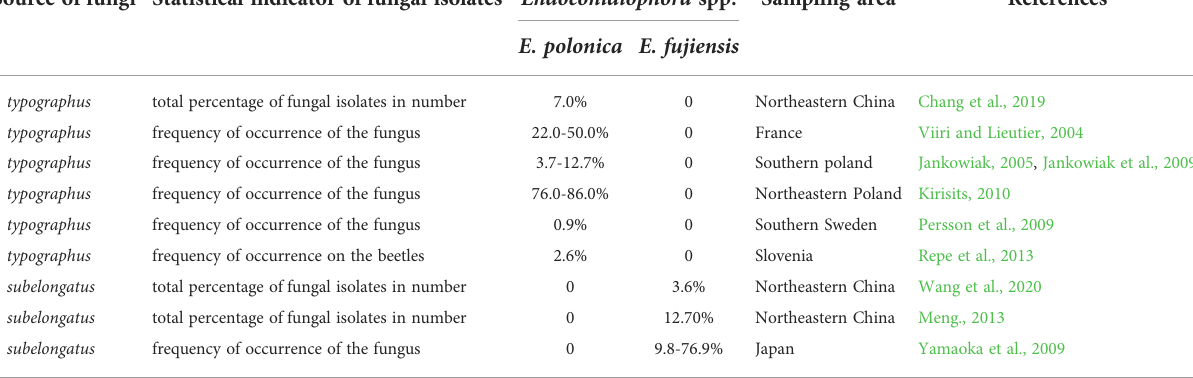
TABLE 1 Selected information from research on Endoconidiophora fungi isolated from two Ips bark beetles. Source of fungi Statistical indicator of fungal isolates Endoconidiophora spp. Sampling